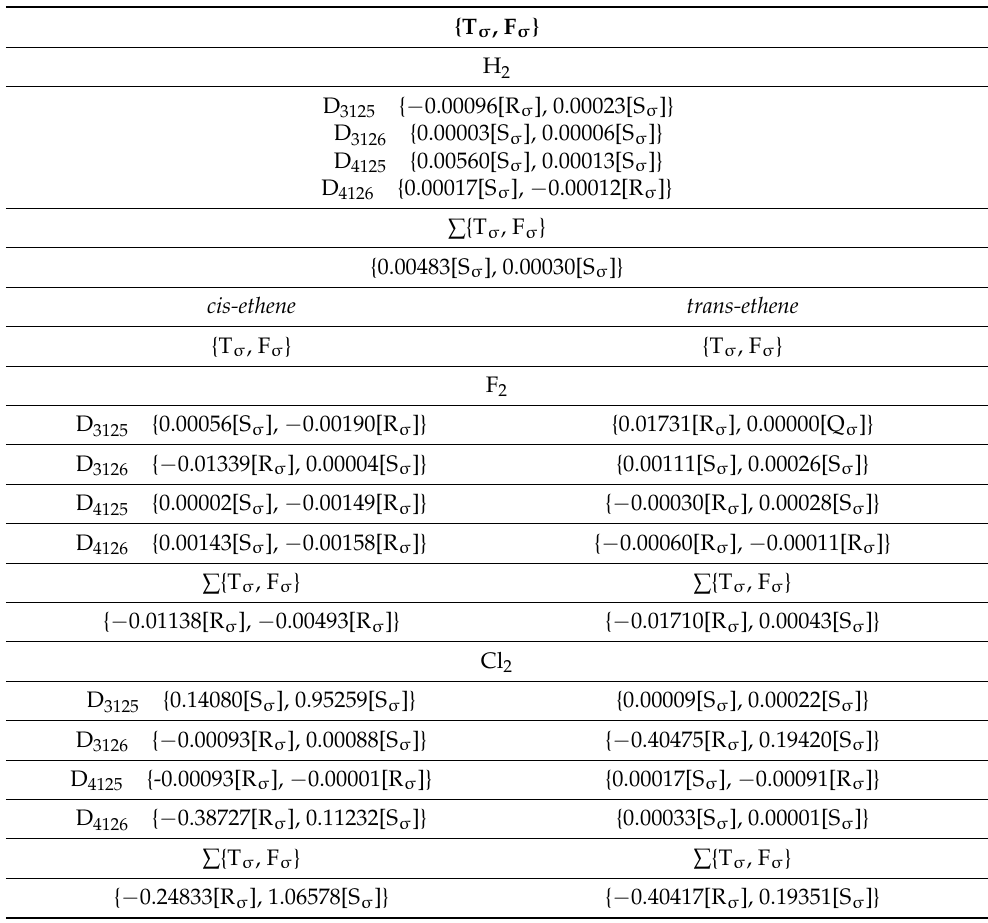
Table 1. The U σ -space bond cross-section sets {bond-twist T σ , bond-flexing F σ } of the torsion C1-C2 BCP, and the sum ∑ {T σ ,F σ }, of ethene and the cis- and trans-isomers of doubly substituted ethene. The atom numbering sequence for the dihedral angles used to construct the T σ (s) is indicated by the four-digit sequence (left column); see Scheme 1.